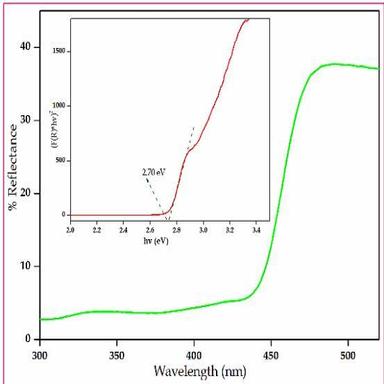
V-Vis spectrum of HAPH Fig. 9 Photoluminescence emission spectra